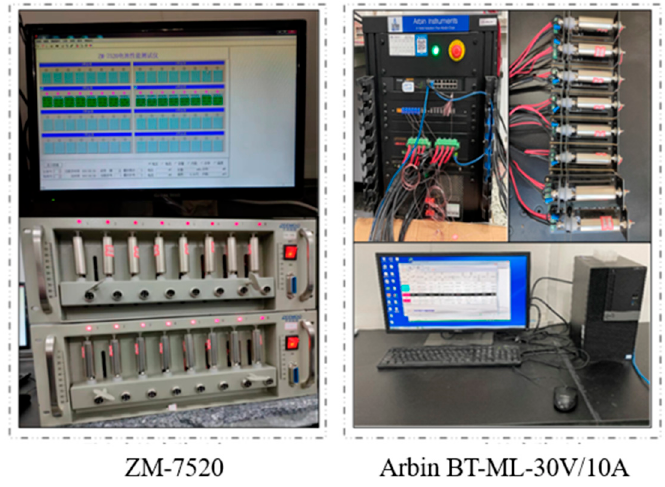
Figure 6. Schematic diagram of battery experiment platform.